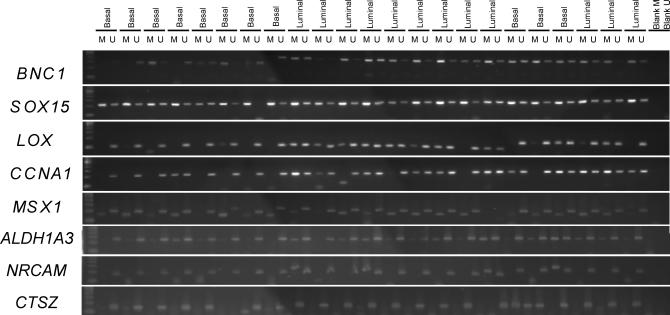
MSP for Indicated Genes in Ductal Breast Carcinoma DNA for Samples Obtained from UNCThe basal phenotype is based on gene expression profiles demonstrated previously and is characterized by the absence of estrogen receptor and a poor prognosis. Other samples are characterized as luminal. Visible bands corresponding to the appropriate size were counted as positive. 100 bp ladder is at far left. M, methylated product; U, unmethylated product.